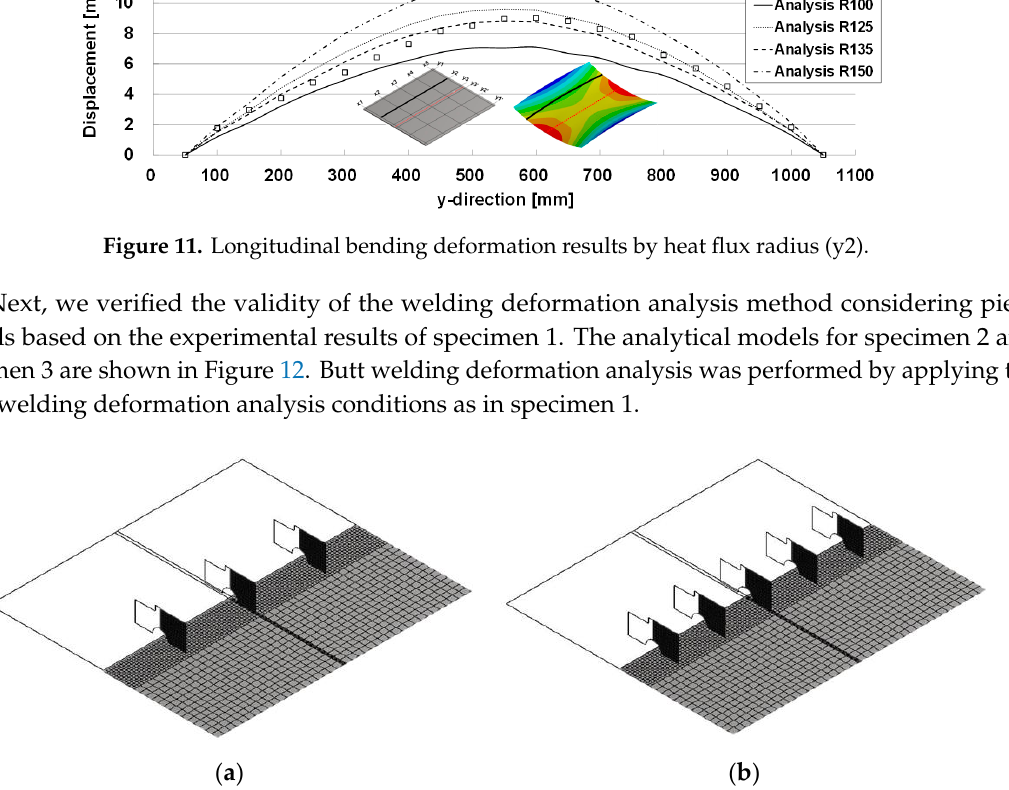
Figure 12. Symmetric finite element models including piece elements: ( a ) specimen 2 and ( b ) specimen 3.